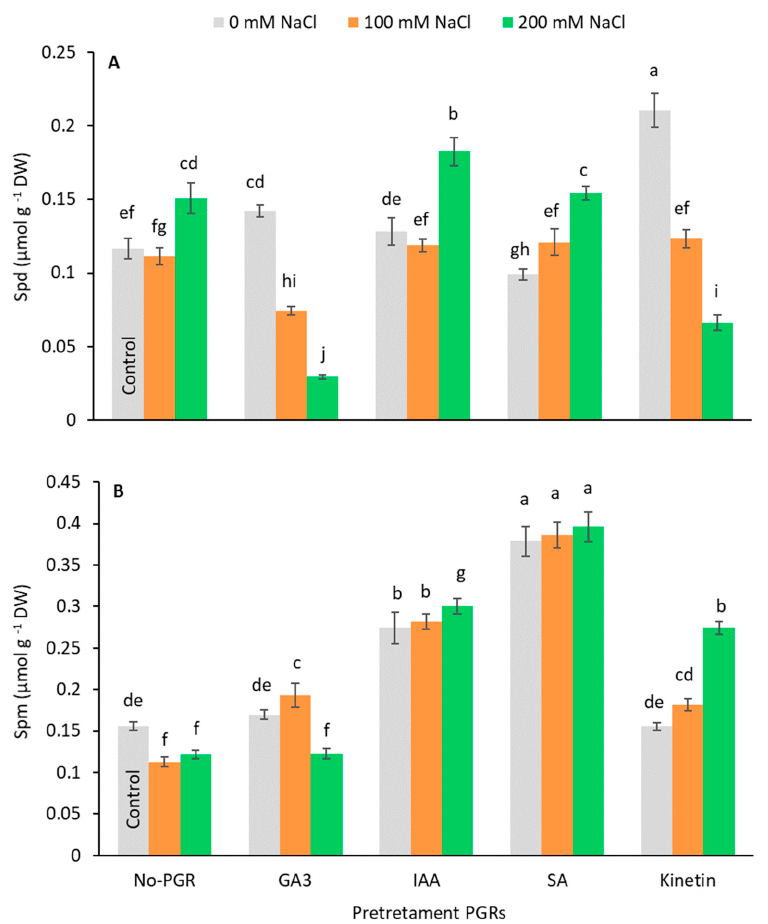
Figure 6. Effect of salt stress on Spd ( A ) and Spm ( B ) contents in leaf of Olea europaea plants pretreated with plant growth regulators (PGRs). Data are expressed as mean ± SE (n = 4). Means followed by the same letter are not significantly different according to the LSD test ( p < 0.05). Compared to the control, ethylene production (Figure 7) fell in all pretreatments at 100 mM NaCl but increased at 200 mM in IAA-pretreated plants and reached its highest levels (4.44 nmol g − 1 FW h − 1 ) in no-PGR plants.